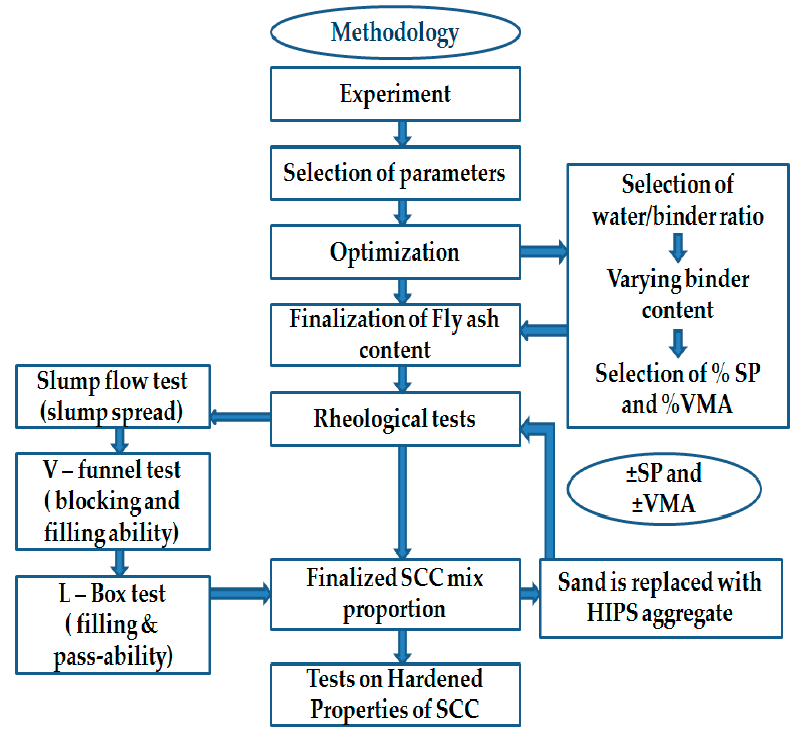
Figure 1. Methodology of self-compacting concrete (SCC) mix Table 1. of self-compacting concrete and optimization of constitute materials. 151